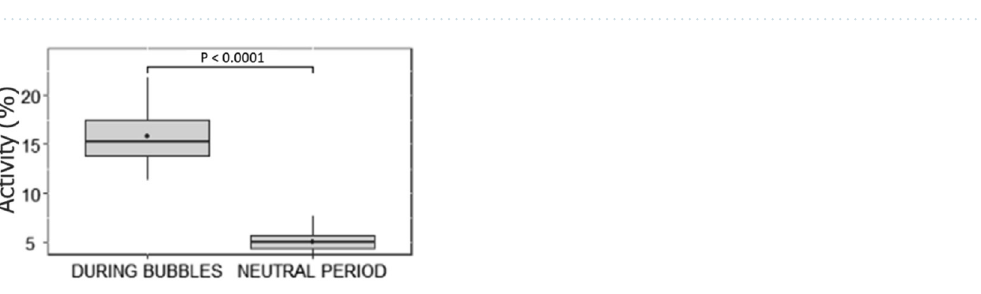
Figure 1. Median (quartiles: 25%, 75%) percentage of fish group activity (% of differing pixels between two successive images) on ( A ) day 1 and on ( B ) day 12 of conditioning. Activity is measured in the bubble area during the 15 s of bubbles until the 5 s of time gap after bubbles for all treatments, corresponding to the period before the expected feeding for treatments BUBBLE + TIME and BUBBLE (total analysis duration of 20 s). The black point inside boxes represents the mean value (Tukey post-hoc tests).